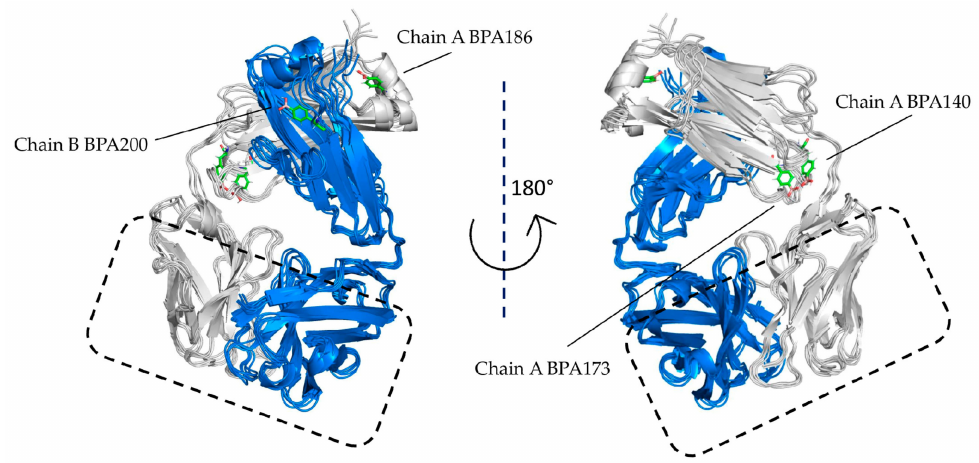
Figure 8. Comparison of protein structures: 3D superimposition of representative structures obtained from cluster analysis shows structural similarity among wild type and boronated proteins, especially in the EGFR interaction